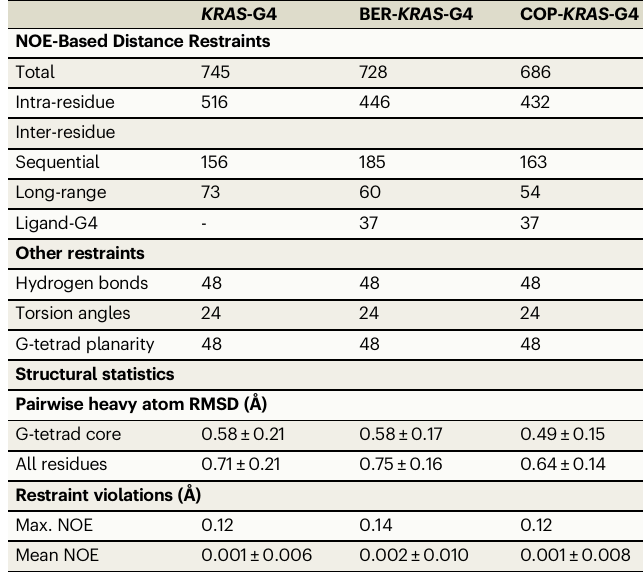
Table 1 | NMR restraints and structural statistics for the free KRAS -G4 and its complex with berberine and